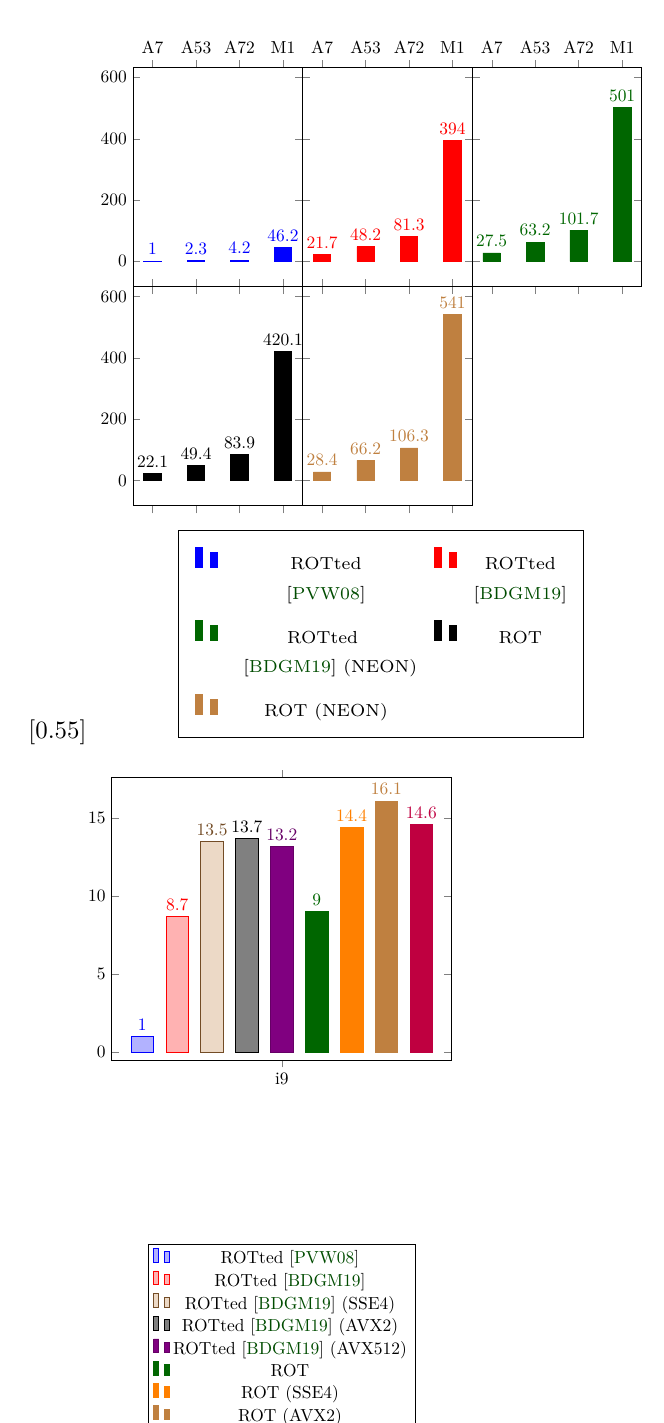
Figure 6: Speedup for the x86 device, for the proposed ROT, and black-box transformation of SotA OTs [PVW08, BDGM19] into ROTs. ROTted [PVW08] is the